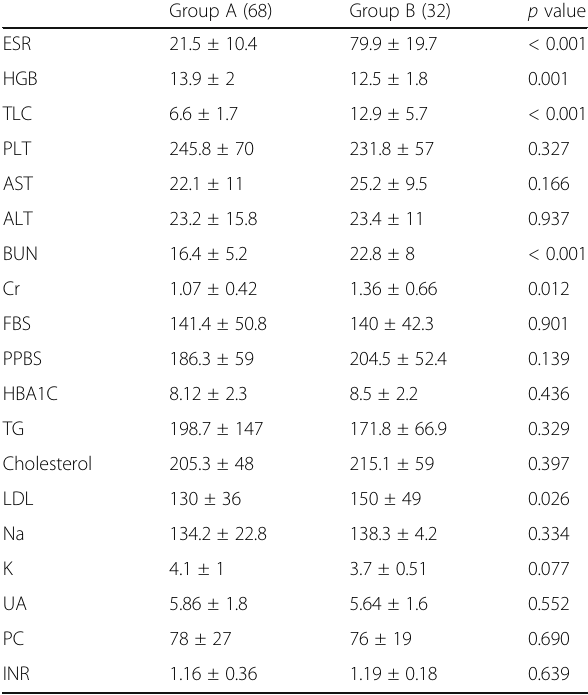
Table 6 Laboratory values of our study